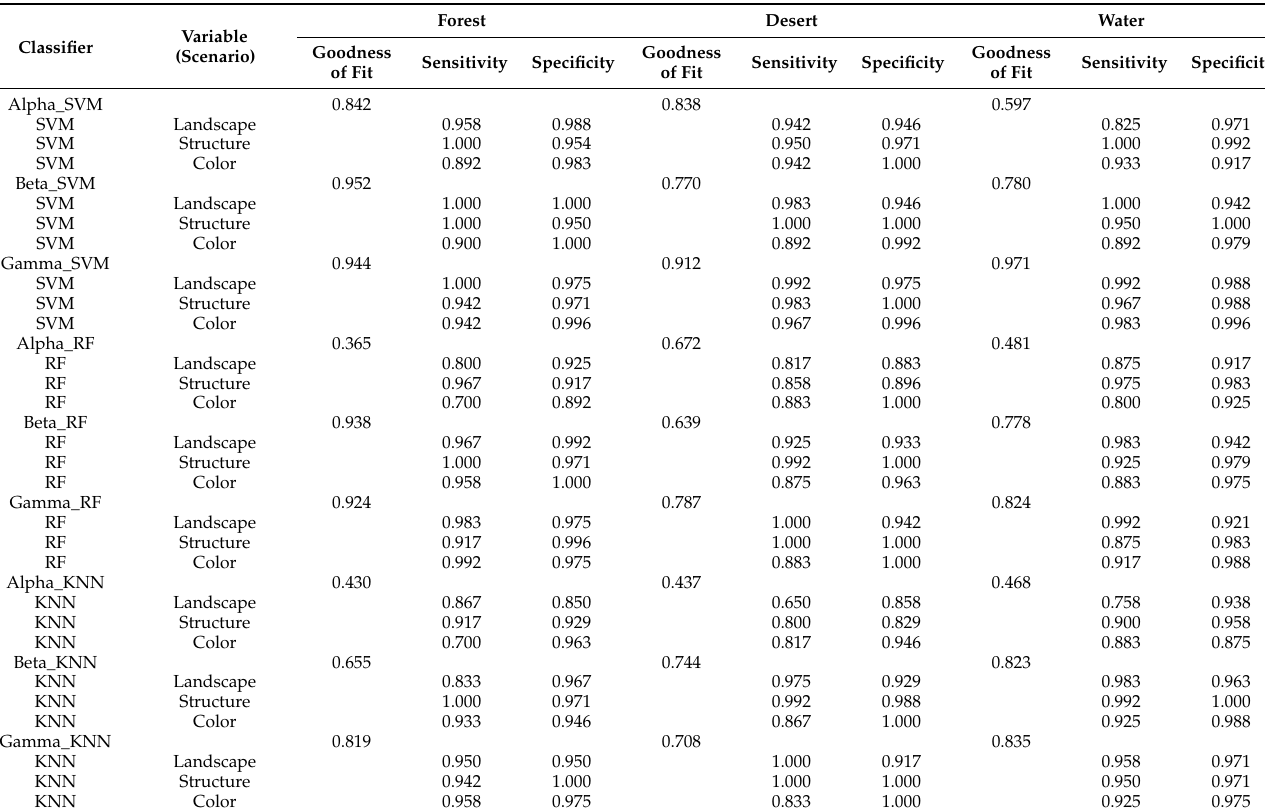
Table A1. The goodness of fit, specificity, and sensitivity of different classifiers for different landscape types.